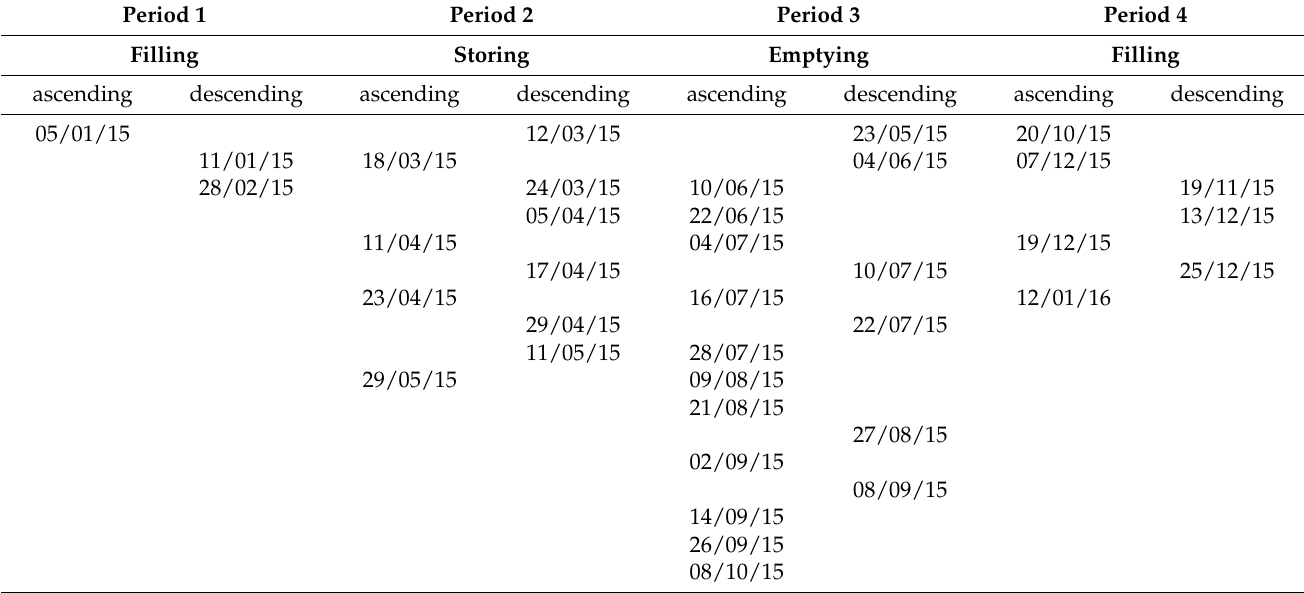
Table 1. TOPSAR S-1A